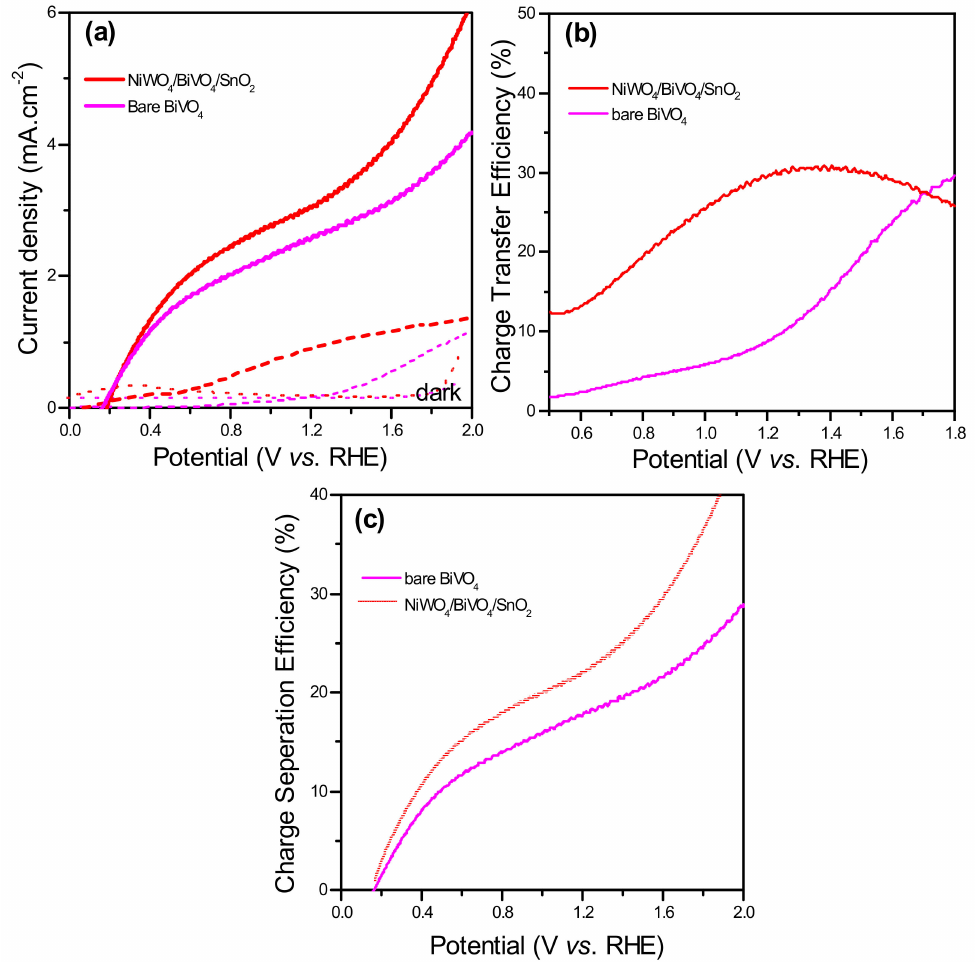
Figure 6. Photoelectrochemical (PEC) in presence of a hole scavenger ( a ) Comparison of the photocurrent-potential plots of the triple layered NiWO 4 / BiVO 4 / SnO 2 films using a PBS solution (0.1 M pH 7.5) with respect to bare BiVO 4 in the presence and absence of 0.5 M H 2 O 2 hole scavenger, respectively. (Solid line: with H 2 O 2 ; dashed line: without H 2 O 2 ). Calculated ( b ) charge-transfer e ffi ciency ( η CT ) and ( c ) charge separation e ffi ciency ( η CS ) versus the applied bias for the bare-BiVO 4 (red) and NiWO 4 / BiVO 4 / SnO 2 (magenta)